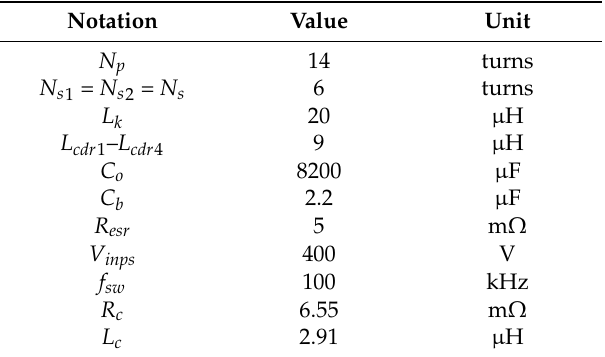
Table 7. Circuit parameters of PSFB-PCDR.